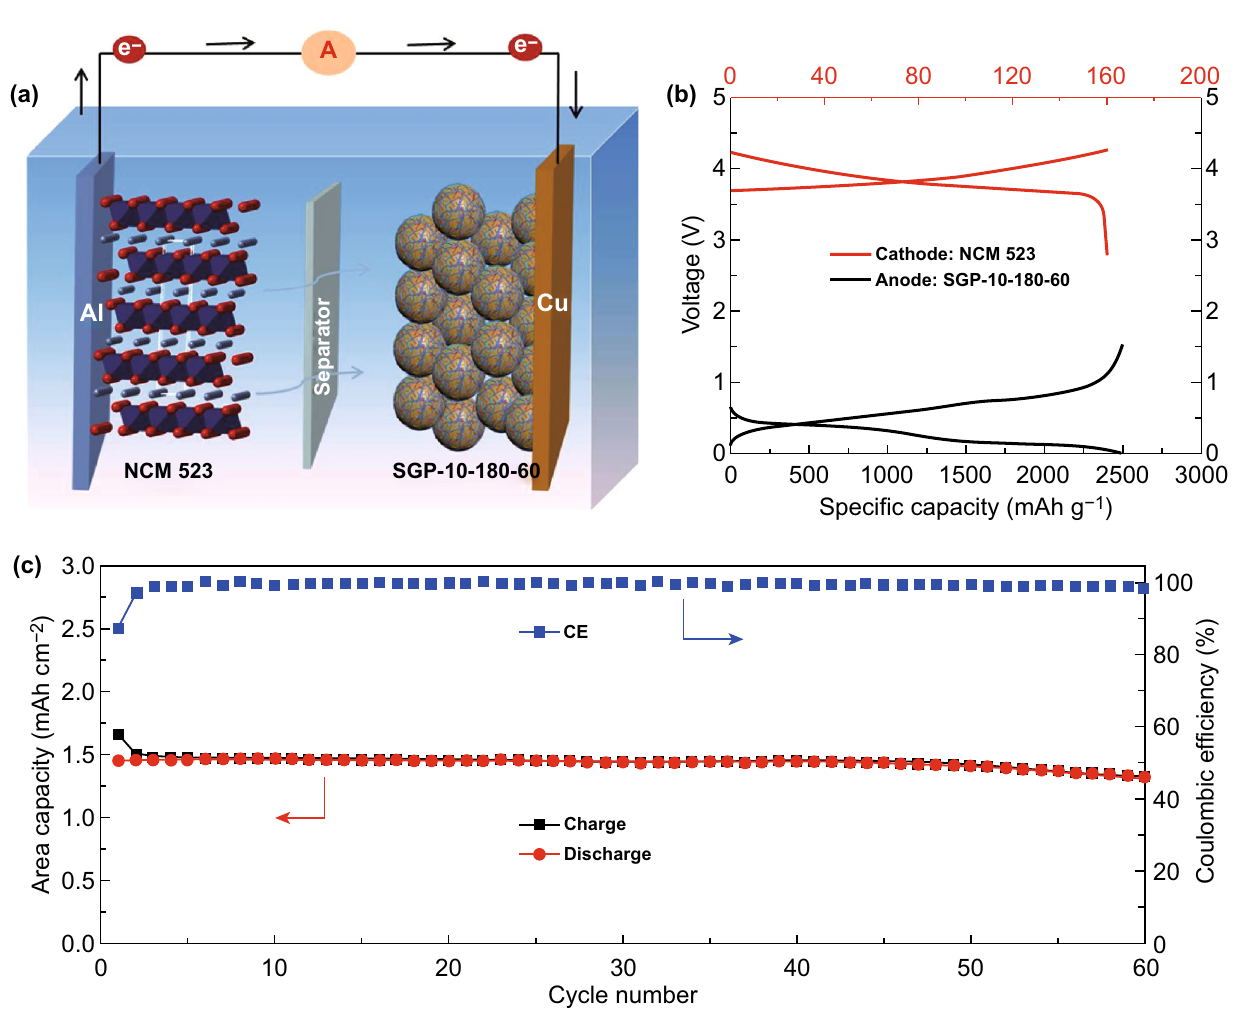
Fig. 7 a Diagram of full battery assembly, the mass loading (10 mg cm −2 ) of an NCM 523 cathode vs. a capacity balanced SGP-10-180-60 anode. b Typical cathode/anode cycling plots. c Cycling performance of full-cell at 20 mA g −1 with prelithiated SGP-10-180-60 anode and